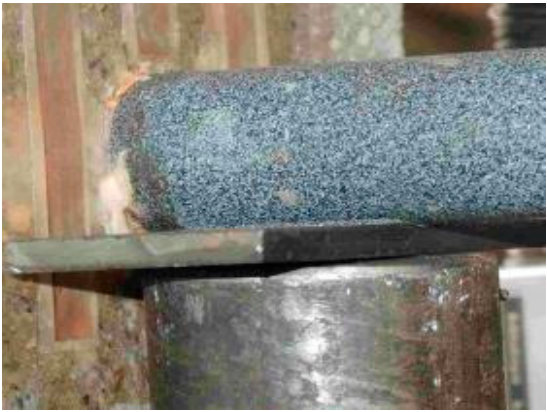
Figure 4. Extrusion of polyethylene (PE) plastic dowel coating during loading test of beam with inserted dowel.